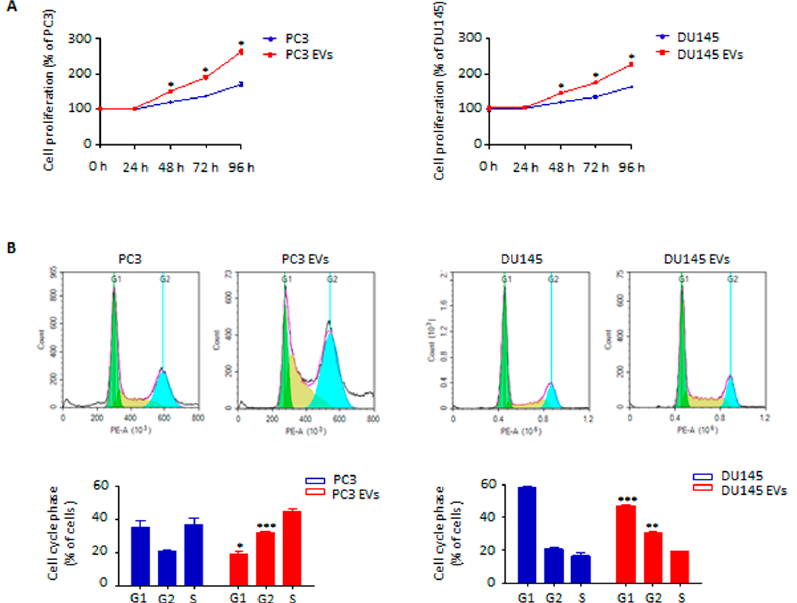
Figure 2. Adipocyte-released EVs promote prostate cancer cell proliferation. ( A ) PC3 and DU145 cells were incubated with adipocyte-released EVs (30 μ g/mL) for 96 h. Cell proliferation was then evaluated by Trypan Blue exclusion assay. Each experiment was repeated three times. Data represent mean values ± SEM and were analyzed using a t-test. * p < 0.05 vs. PC3 or DU145 (control). ( B ) Cells were incubated with adipocyte-released EVs (30 μ g/mL) for 24 h. Cell cycle distribution was then evaluated by cytofluorimetric analysis after staining with Invitrogen™ FxCycle™ PI/RNase Staining Solution (according to the manufacturer’s protocol). Each experiment was repeated three times. Data represent mean values ± SEM and were analyzed using a t-test. * p < 0.05 vs. PC3 or DU145 (control), ** p < 0.01 vs. PC3 or DU145 (control), *** p < 0.001 vs. PC3 or DU145 (control).